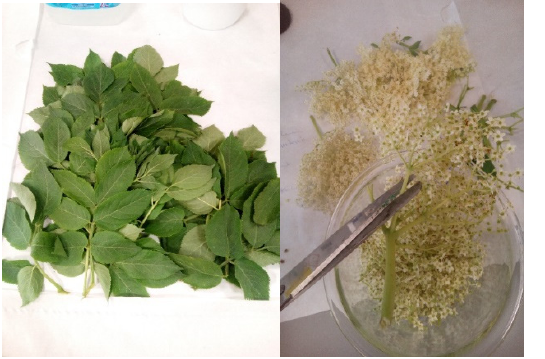
Figure 1. Sambucus tree